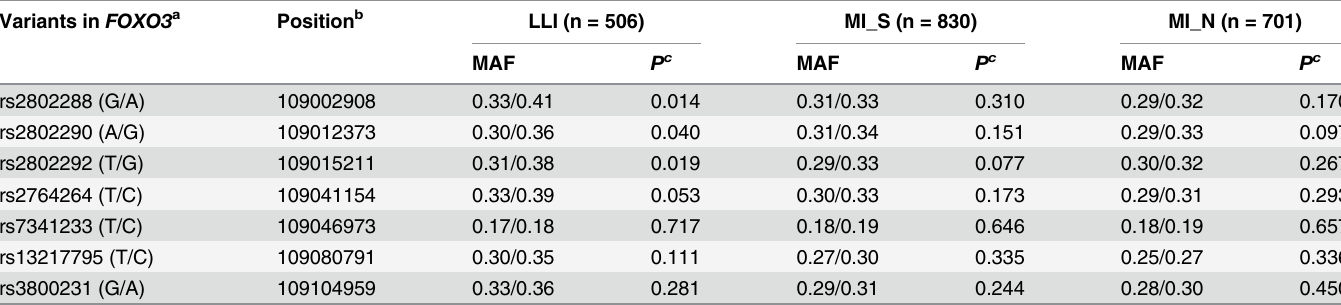
Table 2. Minor allele frequencies of the FOXO3 tSNPs in three